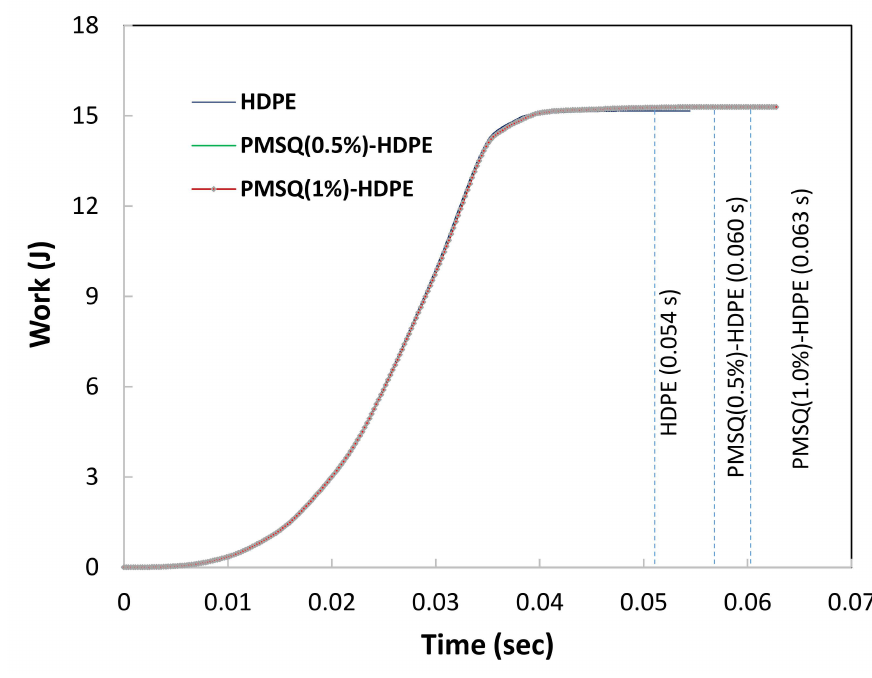
Figure 13. Work done by the gas at the end of the forming cycle for HDPE, HDPE-PMSQ1 and HDPE-PMSQ2.